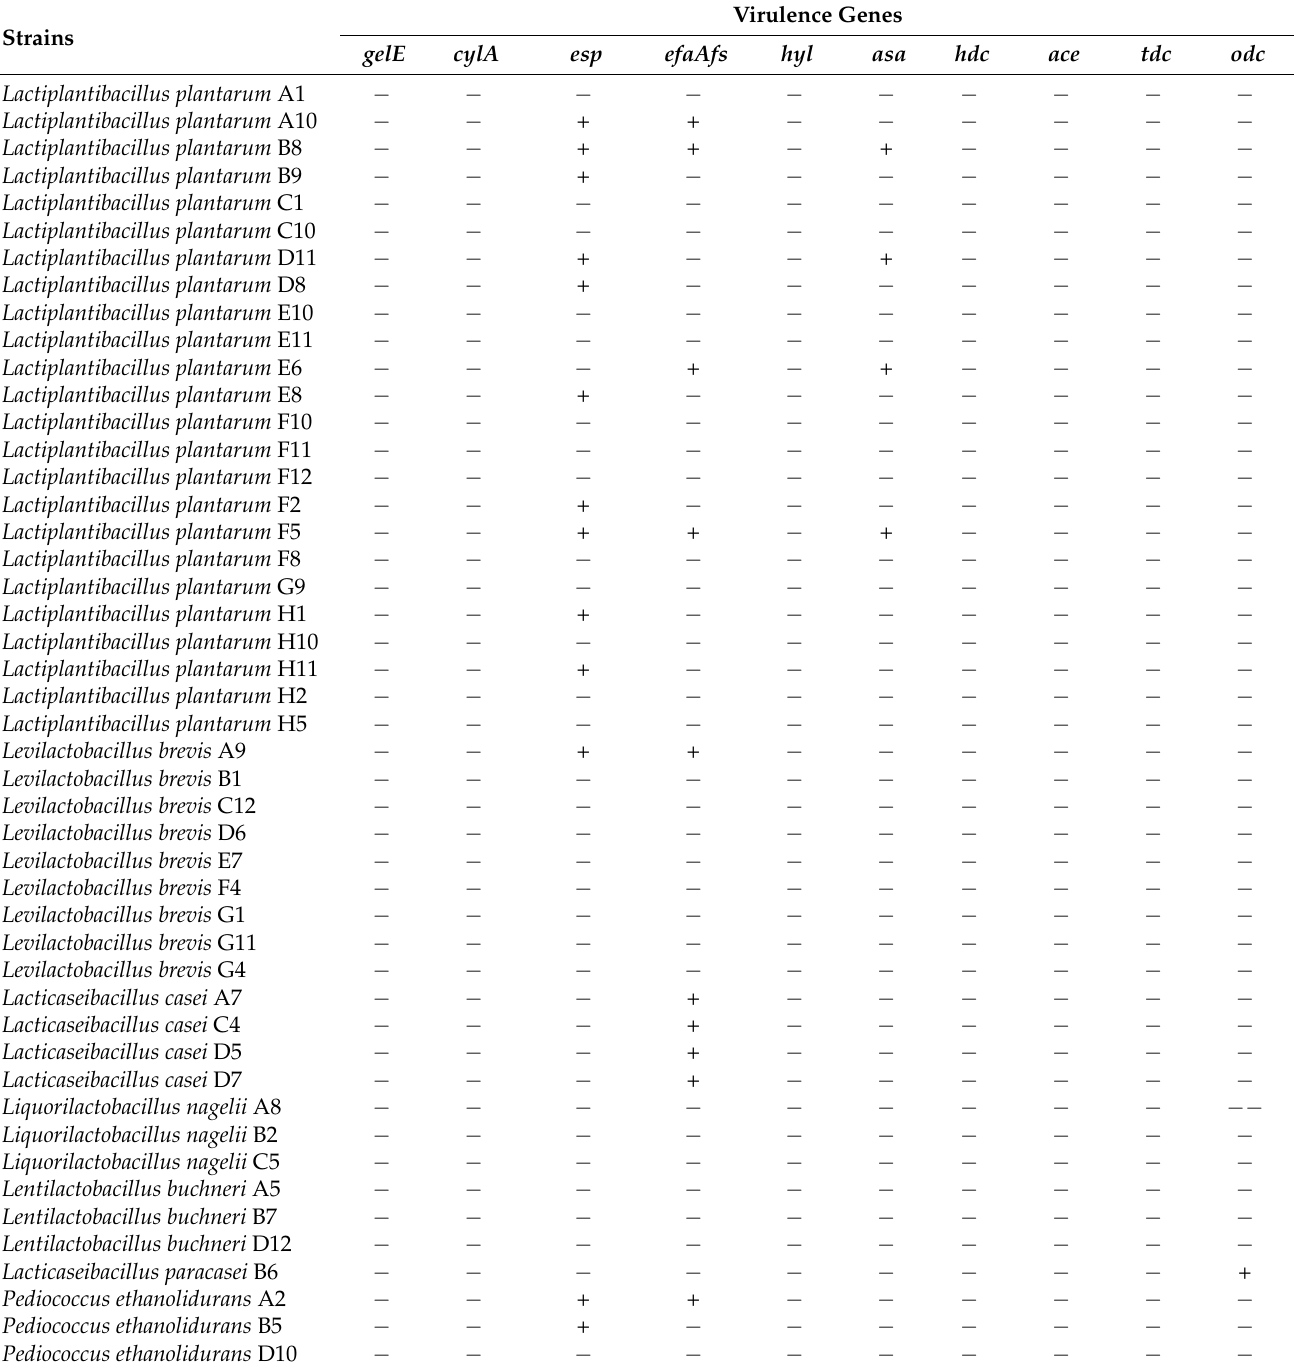
Table 2. Virulence gene detection in the LAB